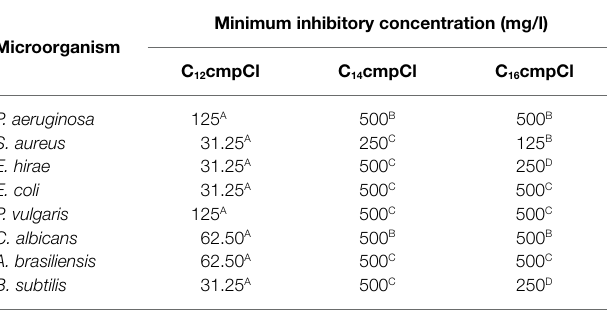
TABLE 4 | Determination of the minimum inhibitory concentration of a series of cationic surfactants. Minimum inhibitory concentration Microorganism